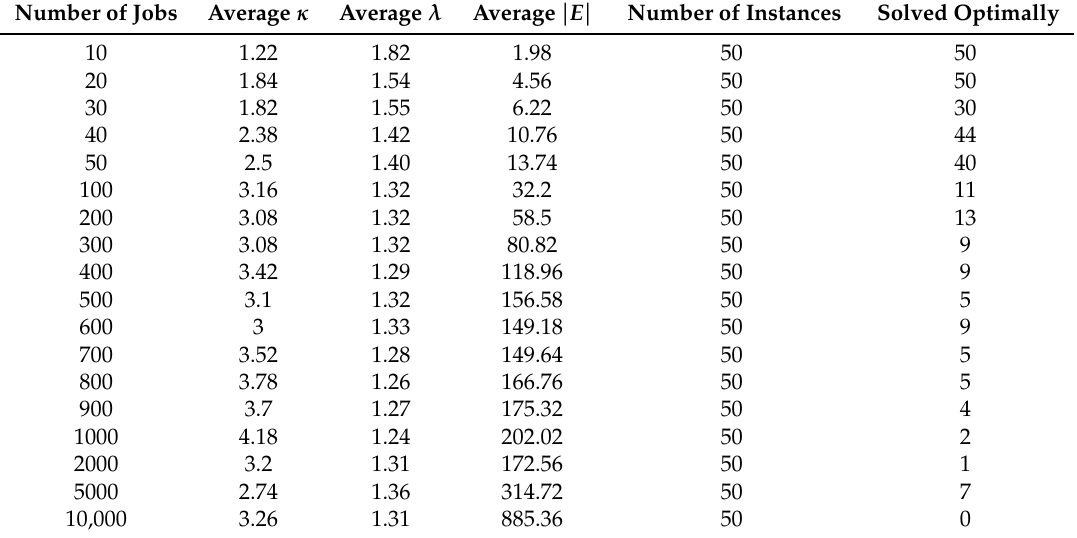
Table 9. The average number of kernels and the guaranteed approximation factor for each group of the difficult